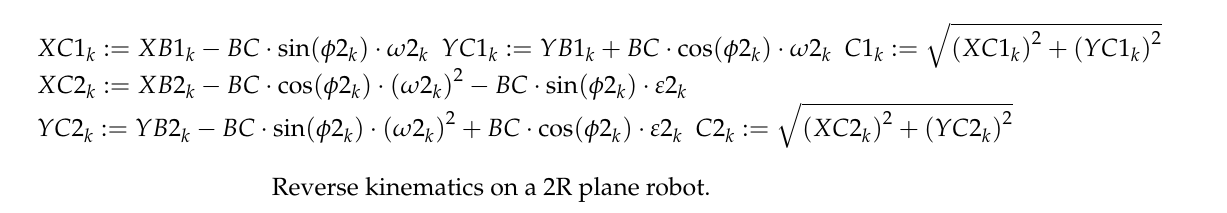
Figure A6. On the left side are the scalar coordinates of the speed of point B (red and blue) and its absolute speed (green); on the right the graphs of the accelerations of the same point B.